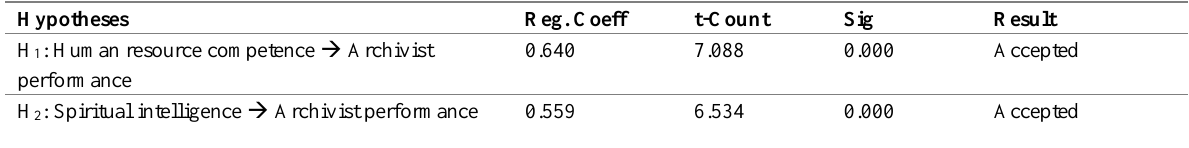
Table 3 : Linear Regression Test for Direct Relationship